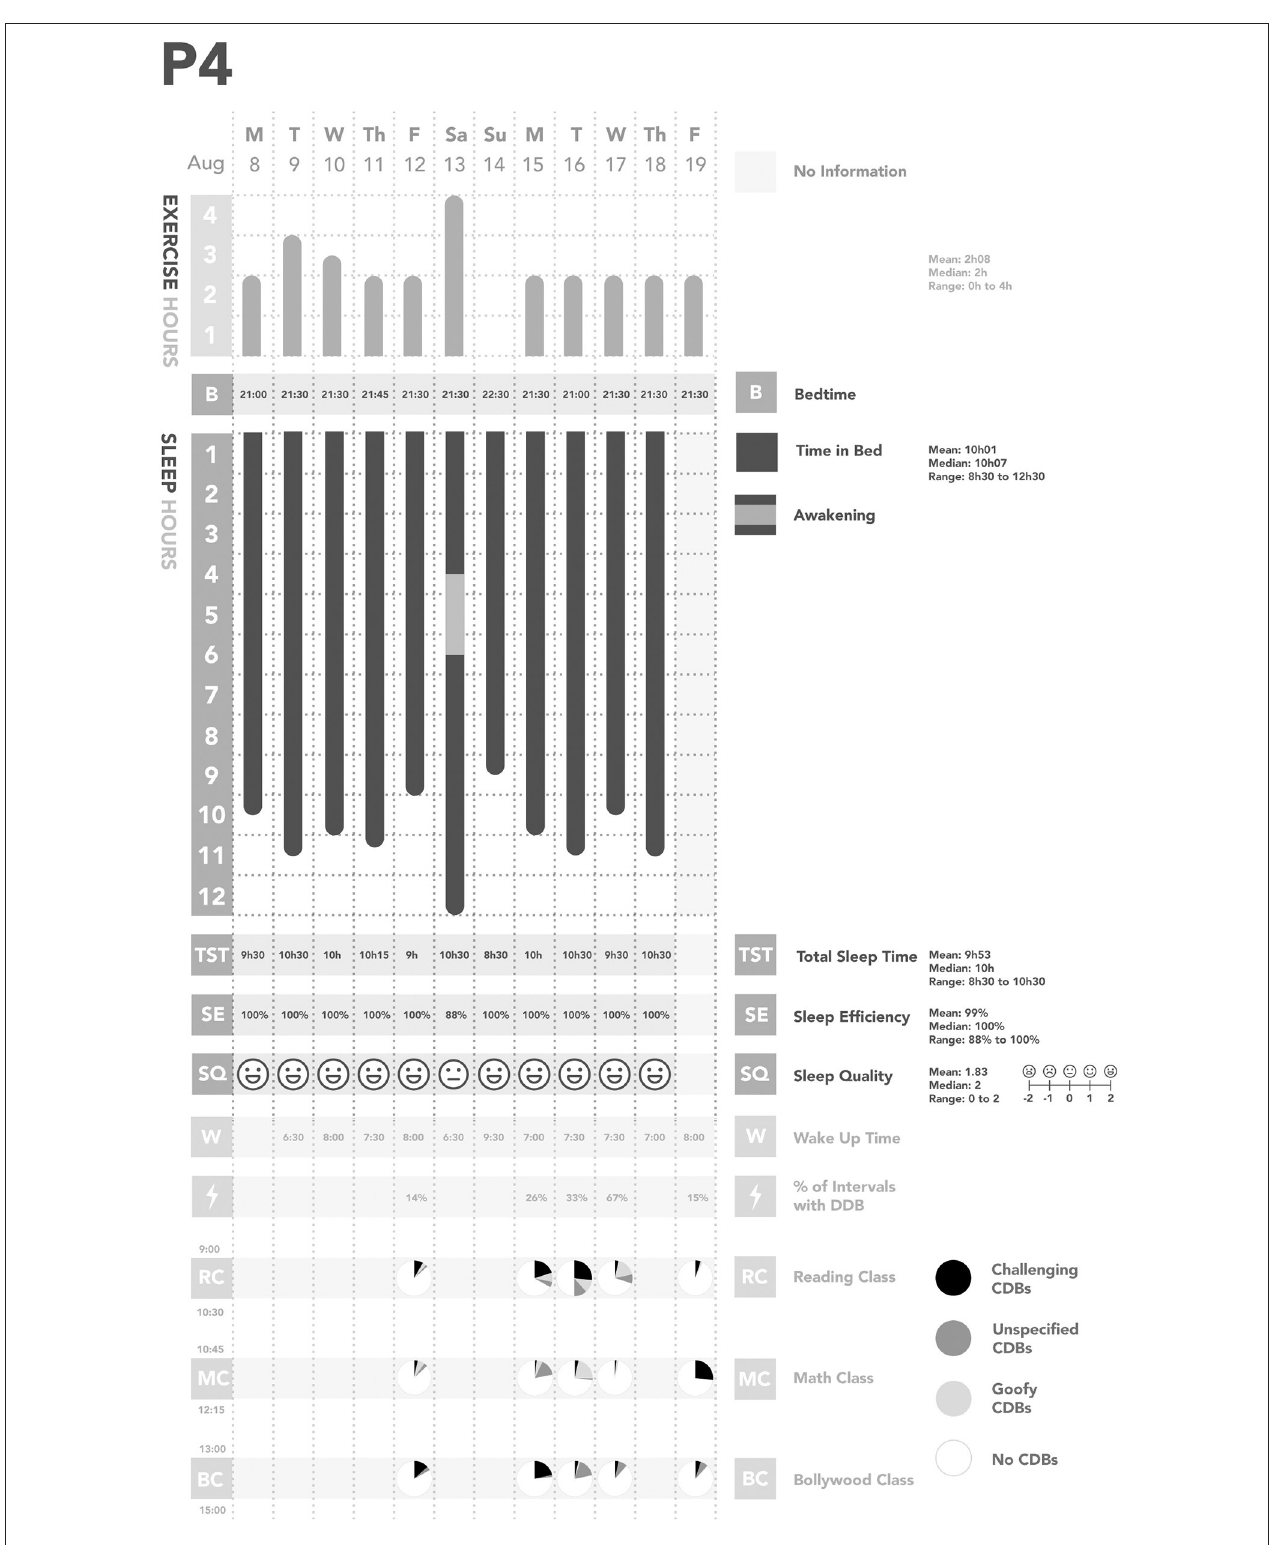
FIGURE 4 | Summary of Participant 4 (P4)’s data. CDBs, Challenging and/or disruptive behaviors.